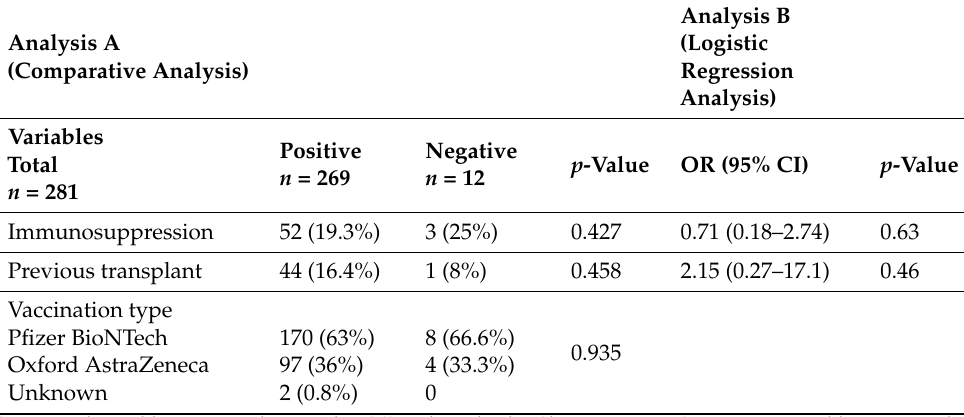
Table 3. Comparison of characteristics of patients who have received double dose vaccination by June 2021, based on breakthrough COVID-19 infection between April 2021 and January 2022. Variables